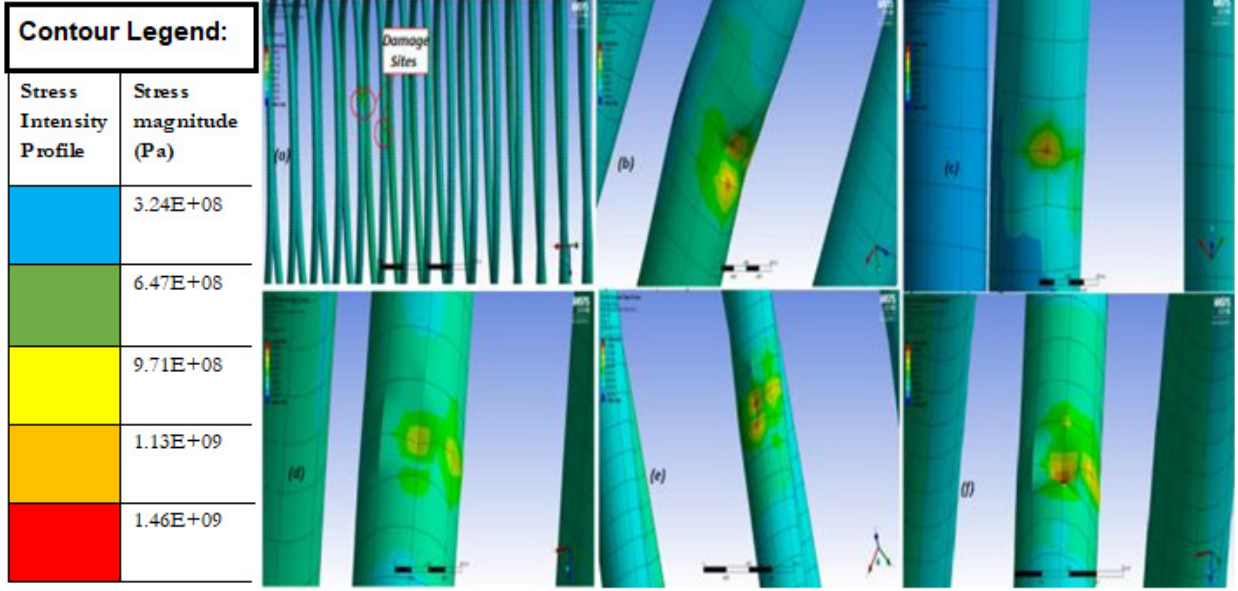
Figure 10. Reinforcement helix’s deformation under extreme conditions showing ( a ) damage sites along different locations on the helix, ( b ) damage site 1, ( c ) damage site 2, ( d ) damage site 3, ( e ) damage site 4, ( f ) damage site 5. All these images ( b – f ) present the stress intensity magnitudes on contour profiles where damage/failure spots and deformations were spotted.